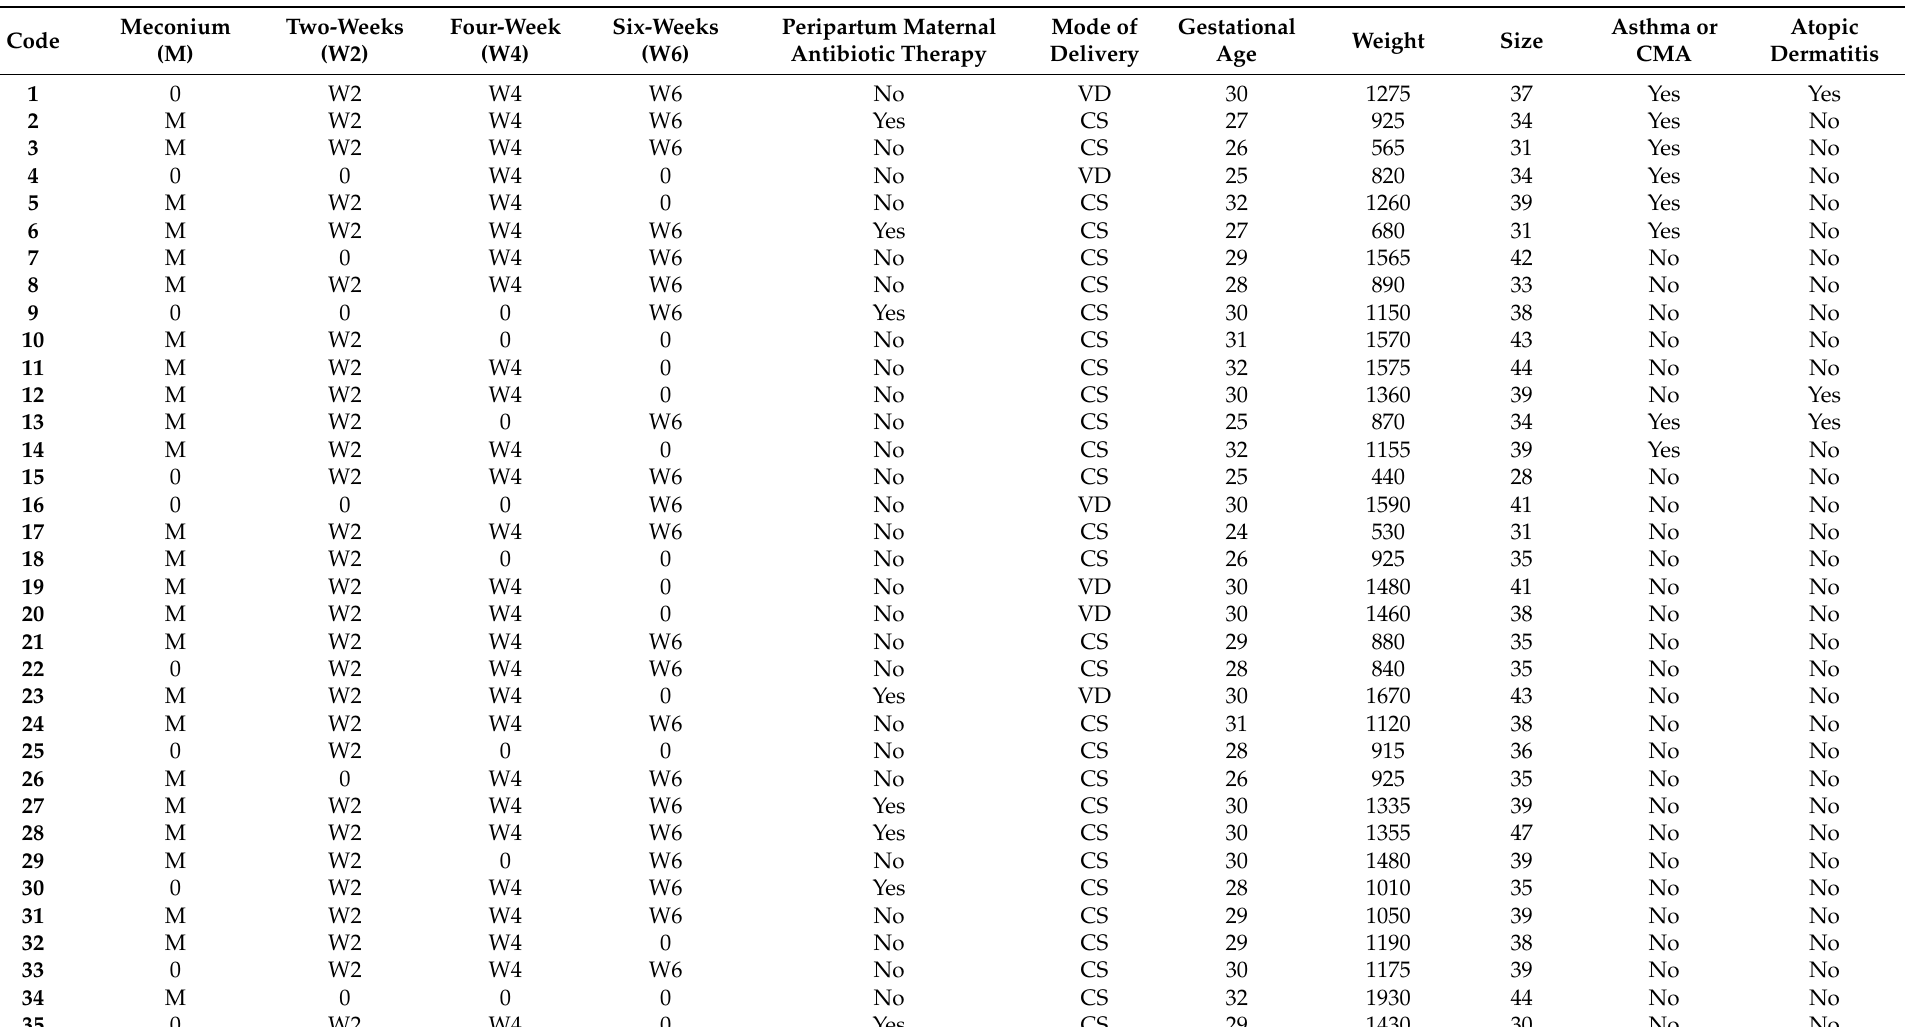
Table 1. Clinical data for preterm infants investigated for the presence of fecal biomarkers. VD: vaginal delivery; CMA, cow’s milk allergy; CS: cesarean